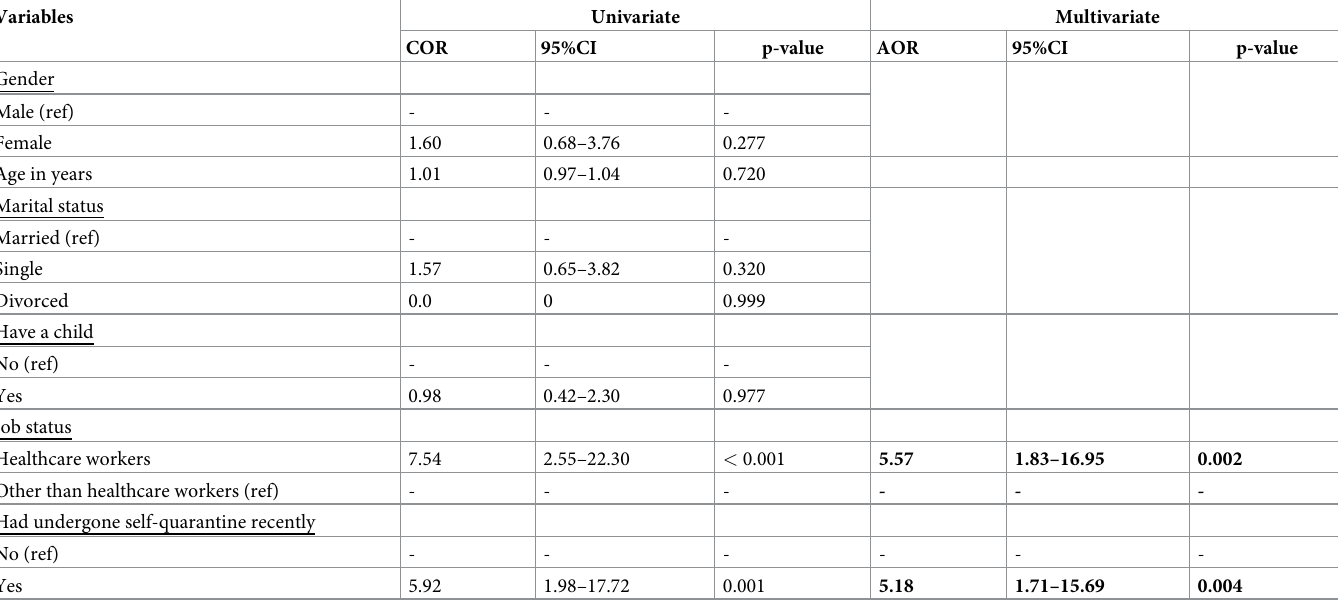
Table 4. Univariate and multivariate logistic regression analysis for depression.